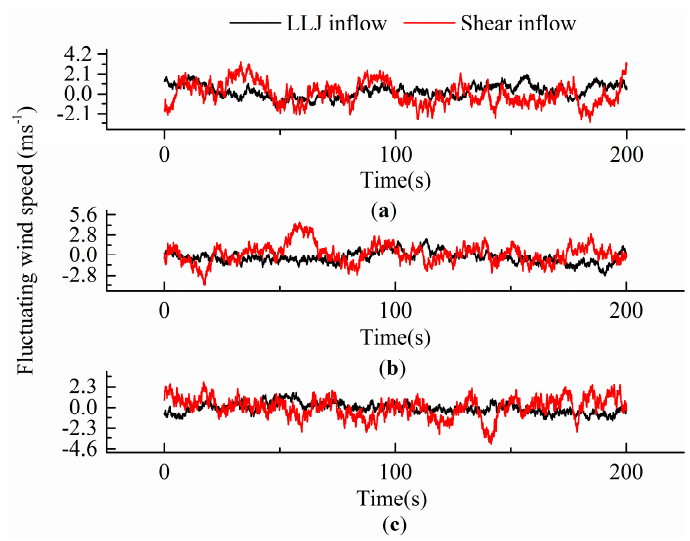
Figure 3. Simulated time-series of the fluctuating wind speed of hub height in the representative LLJ inflow condition and shear inflow condition: ( a ) streamwise, ( b ) transverse, and ( c ) vertical components.